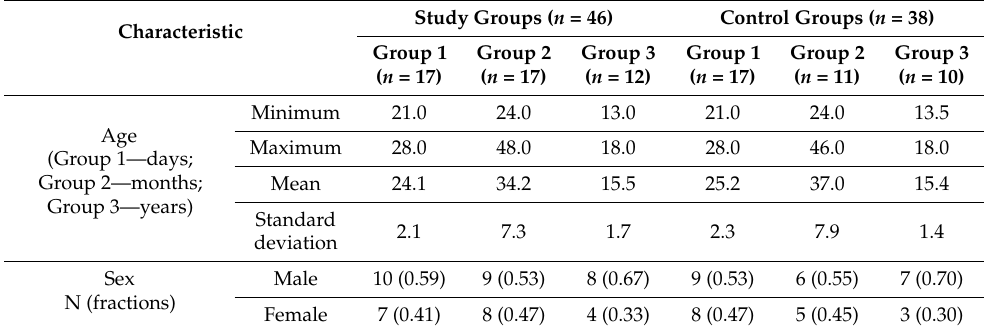
Table 1. The characteristics of the studied